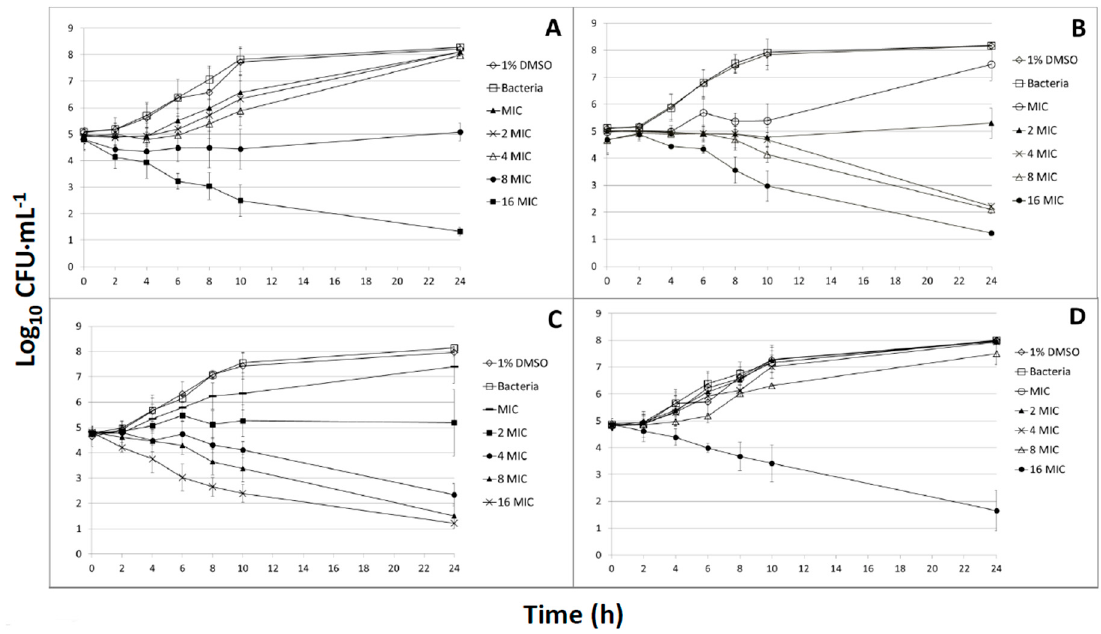
Figure 1. The effect of several concentrations of the four compounds on the growth of S. pyogenes ATCC 19615 at 37 °C: ( A ) 1,2-naphthoquinone (MIC: 3.125 µg mL − 1 ); ( B ) 5-hydroxy-1,4-naphthoquinone (MIC: 1.56 µg mL − 1 ); ( C ) dequalinium chloride (MIC: 0.39 µg mL − 1 ); and ( D ) 4-hexylresorcinol (MIC: 1.56 µg mL − 1 ). Arrows indicate that plate count values were below the detection threshold of 1.22 log 10 CFU mL − 1 .